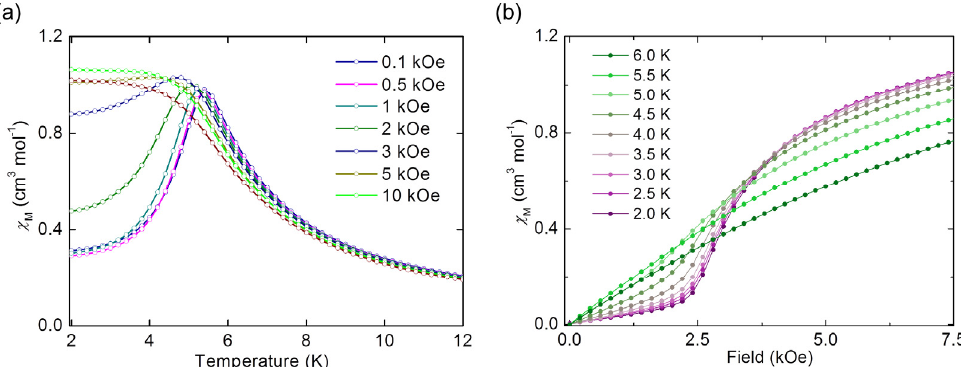
Figure 6. ( a ) The plots of FC magnetization below 12 K at various fields, and ( b ) the plots of field-dependent magnetization under different temperatures of compound 1 .